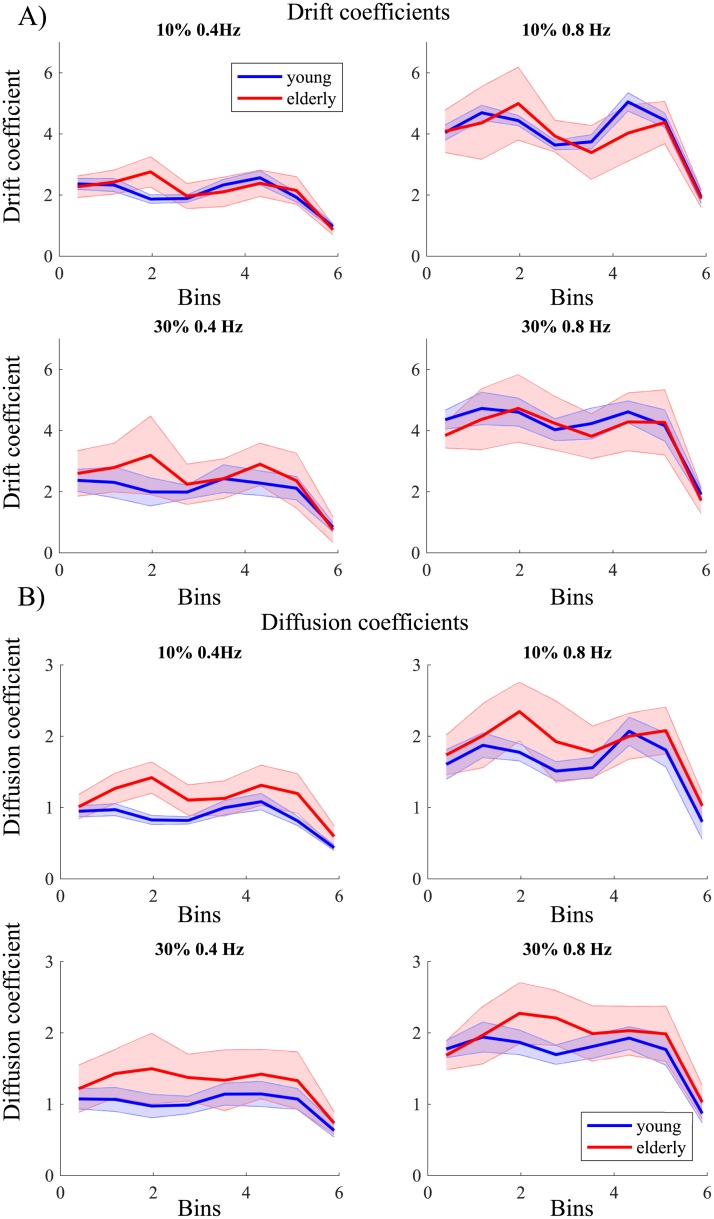
Drift and diffusion coefficients for the modulation task.(A) Drift and (B) diffusion coefficients for 10% and 30% maximum voluntary contraction for a frequency 0.4Hz and 0.8Hz for young (blue) and elderly (red) over bins. The shaded area represents the standard deviation.